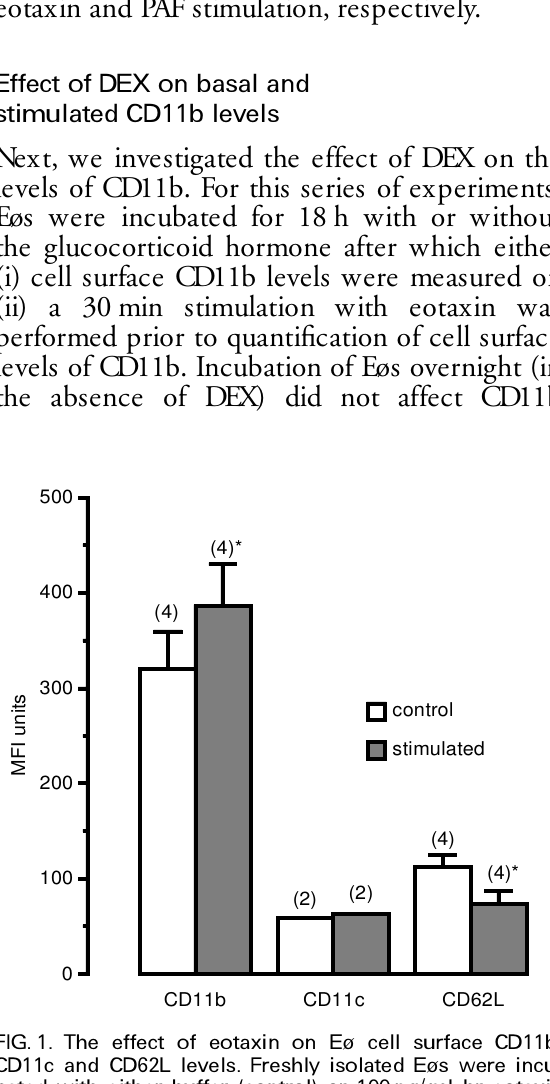
FIG. 1. The effect of eotaxin on Eù cell surface CD11b, CD11c and CD62L levels. Freshly isolated Eù s were incu- bated with either buffer (control) or 100 ng / ml hr eotaxin for 30 min at 37 8 C. Cell surface levels of the adhesion molecules were measured using FACS analysis. Data are mean SEM of ( n ) experiments performed in duplicate. P , 0.05 when compared with appropriate control.